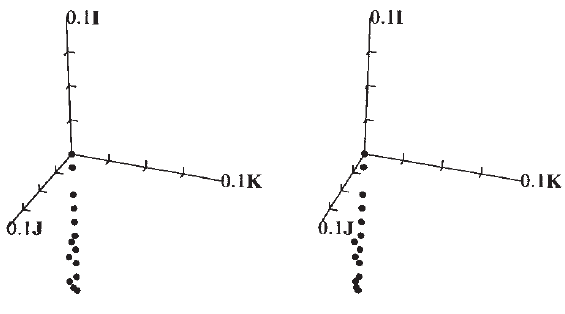
Figure 1c. Scatter plot of 50 measurements of refractive state of a test eye. Operator focused the instrument once, ten measure- ments were taken at a time with no refocusing of the instrument. The instrument triggered itself when adequately focused. Length of axes: 0.1 D. For details see text.